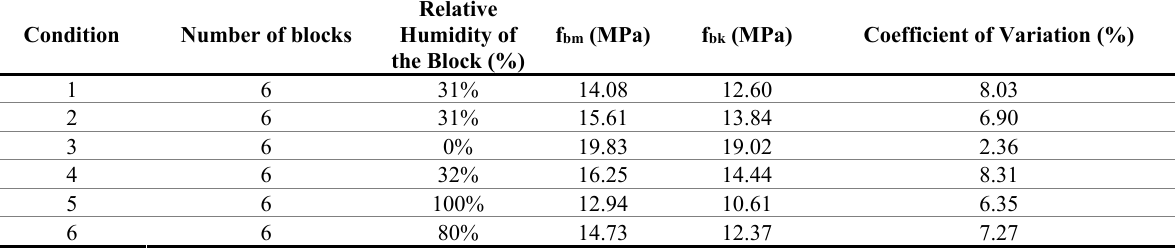
Table 2. Results obtained for group A